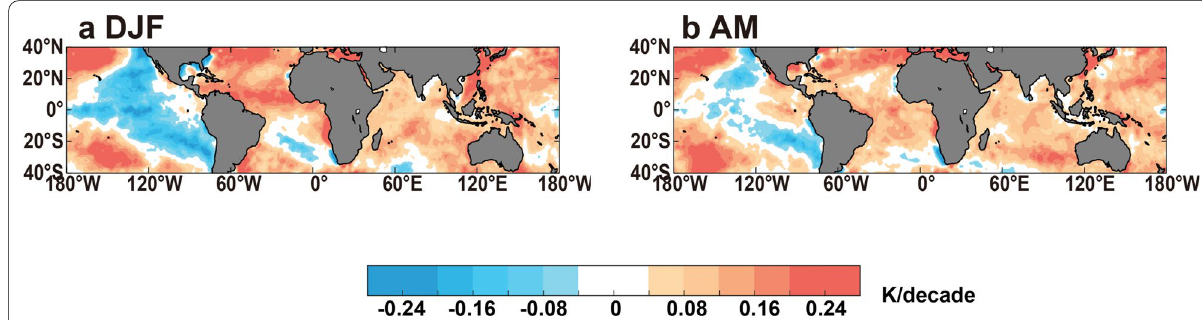
Fig. 4 Observed seasonal HadISST trend from 1979 to 2015. a , b Color mapping represents decadal SST change in DJF and AM